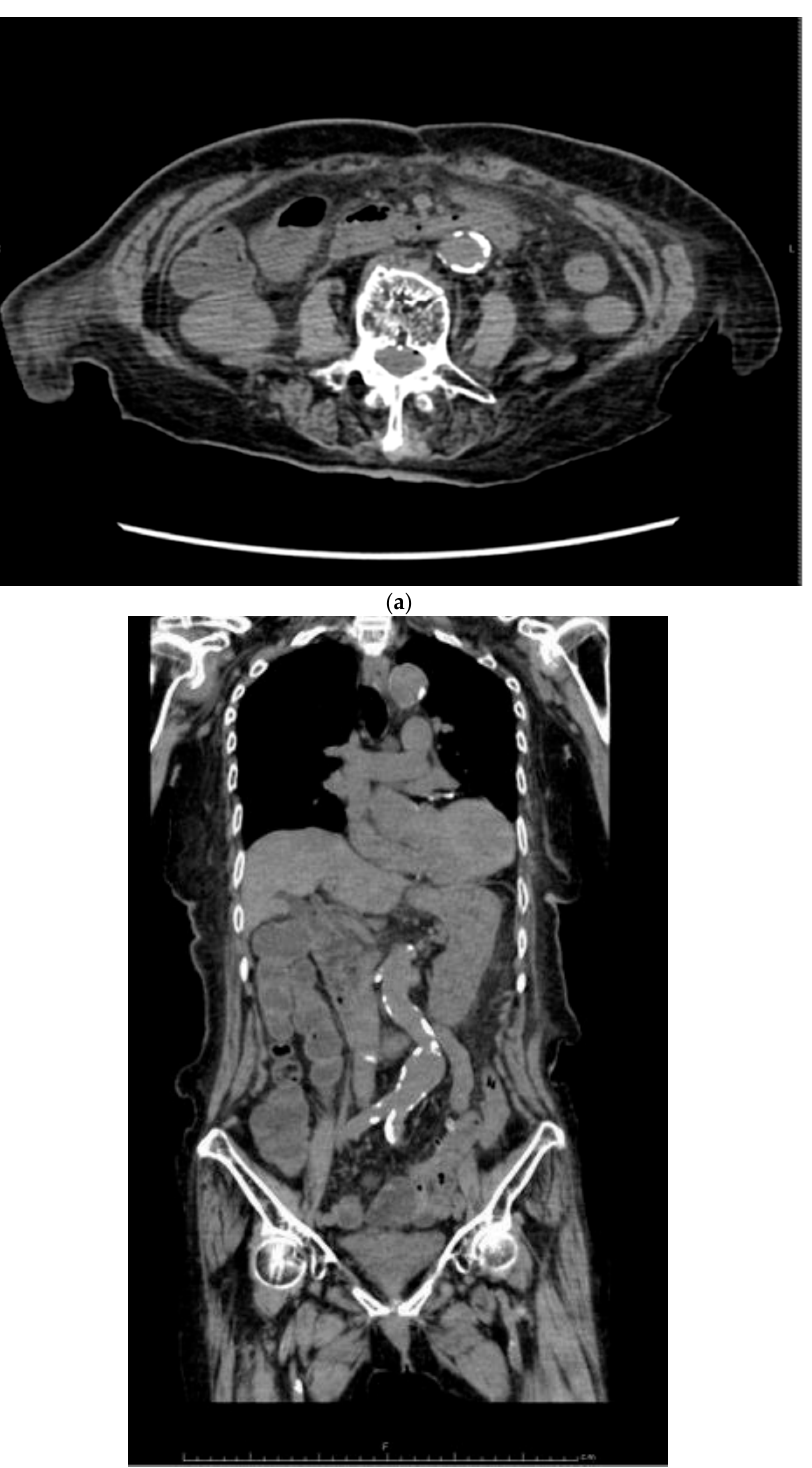
Figure 3. Findings from the abdominal computed tomography scan. Most of small intestine lacked in ( a , b ).